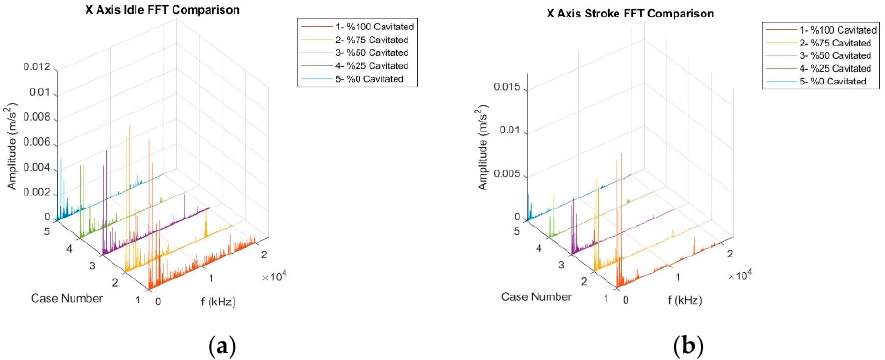
Figure 4. Contaminated oil FFT responses of ( a ) X-axis idle signal and ( b ) X-axis stroke signal.